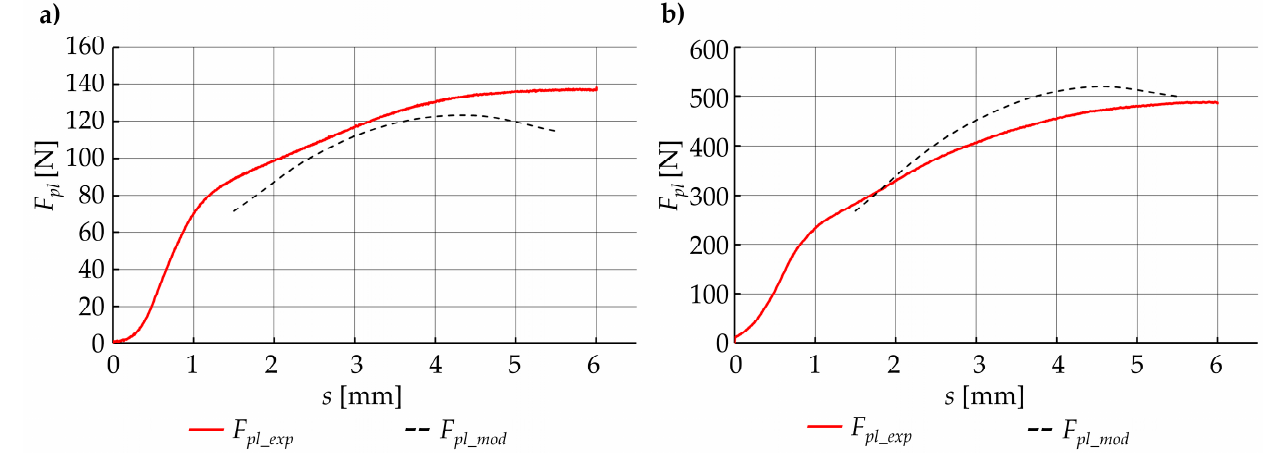
Figure 20. Examples of the characteristics of the plasticization force F pl ( s ) concerning the aspect of comparison between the values of empirical research ( F pl_exp ) and the derivative model ( F pl_mod ): ( a ) belt with diameter of 12 mm, hot plate temperature T p = 285 °C, plasticization velocity v pl = 10 mm/min, ( b ) belt with diameter of 18 mm , hot plate temperature T p = 285 °C, plasticization velocity v pl = 8 mm/min.